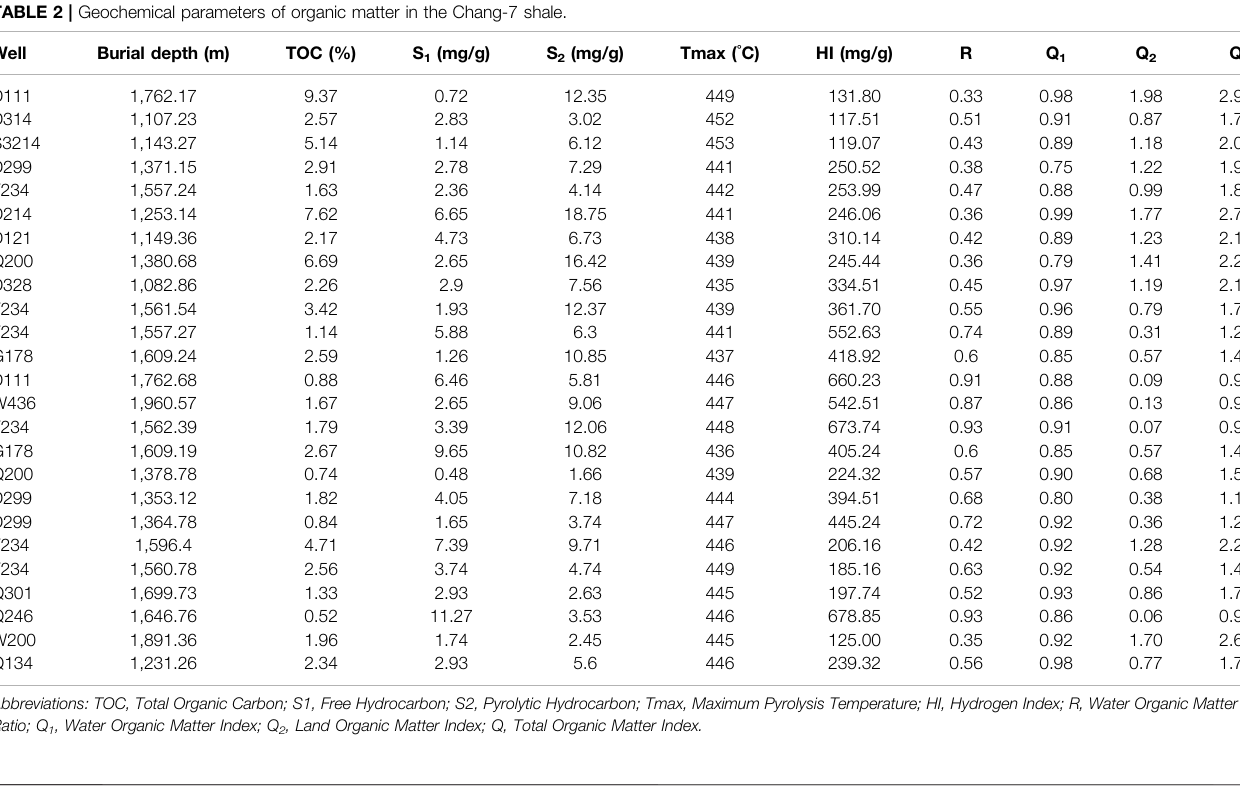
Frontiers in Earth Science |